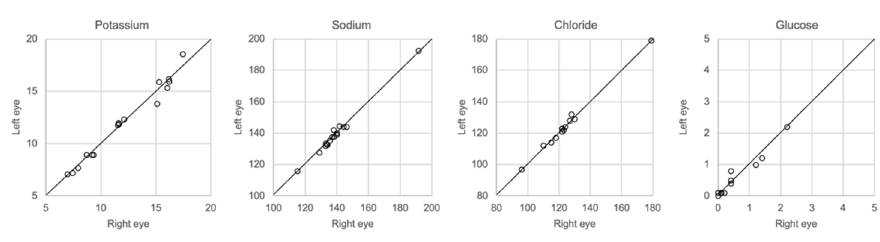
Figure 7. Comparison of samples taken from center of the right and left eye, n = 16.